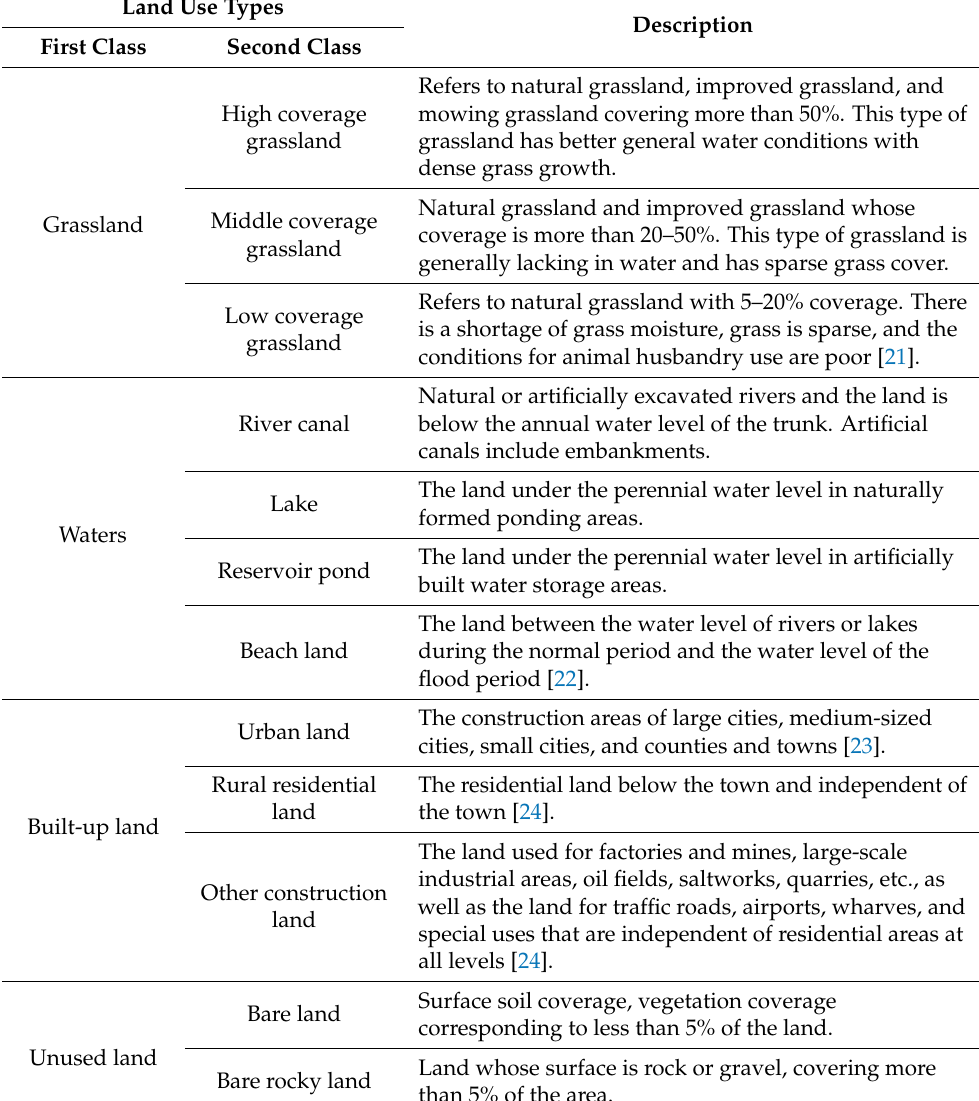
Table 1. Land use classification and its specific